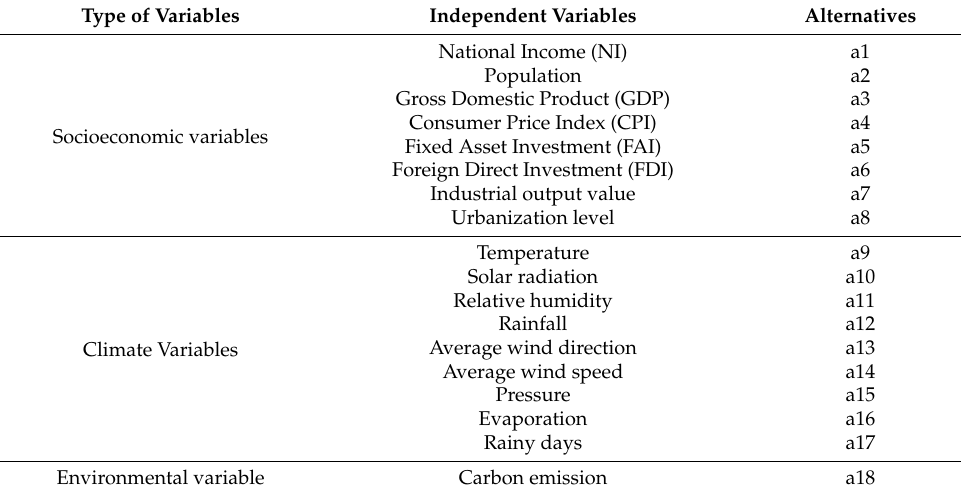
Table 2. Independent variables were selected in the literature